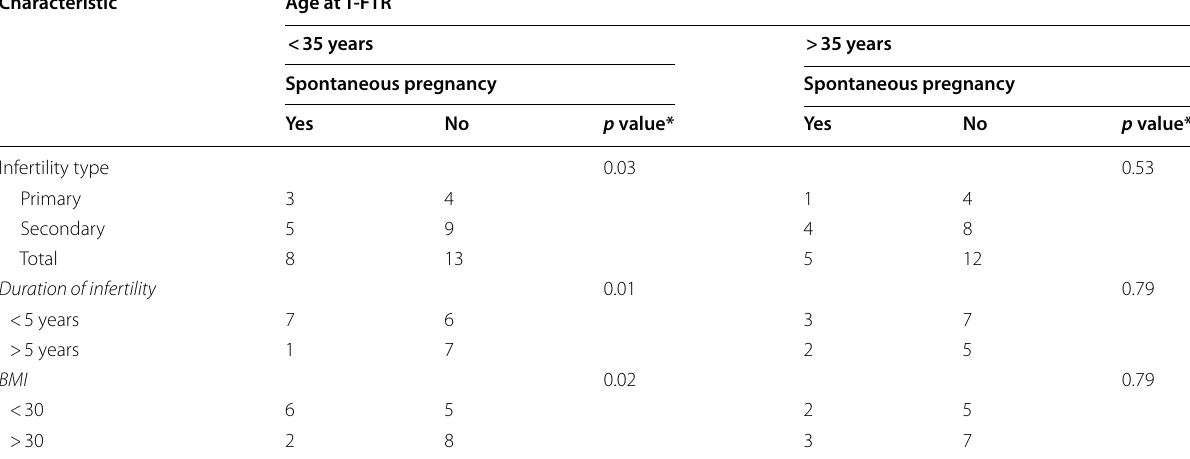
BMI body mass index * Multivariate logistic regression analysis